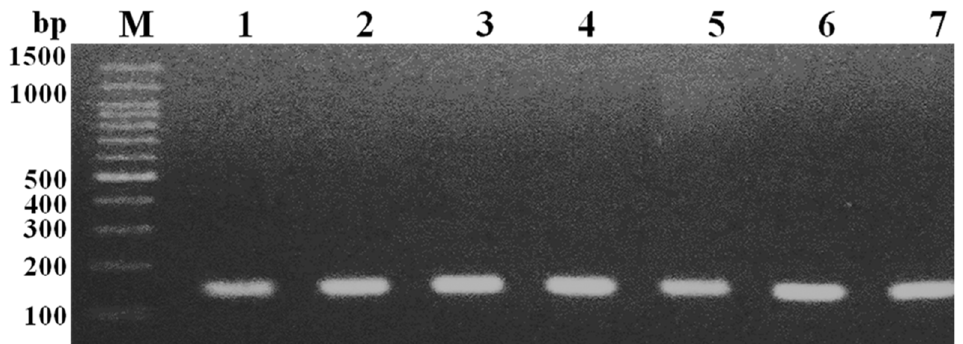
Figure 1. Agarose gel electrophoresis of mec A gene PCR amplicons at about 147 bp. Lanes, M; 100 bp DNA ladder and 1–7; showed the representative some positive results of mec A gene specific bands in phenotypic MRSA isolates 1–7, respectively.